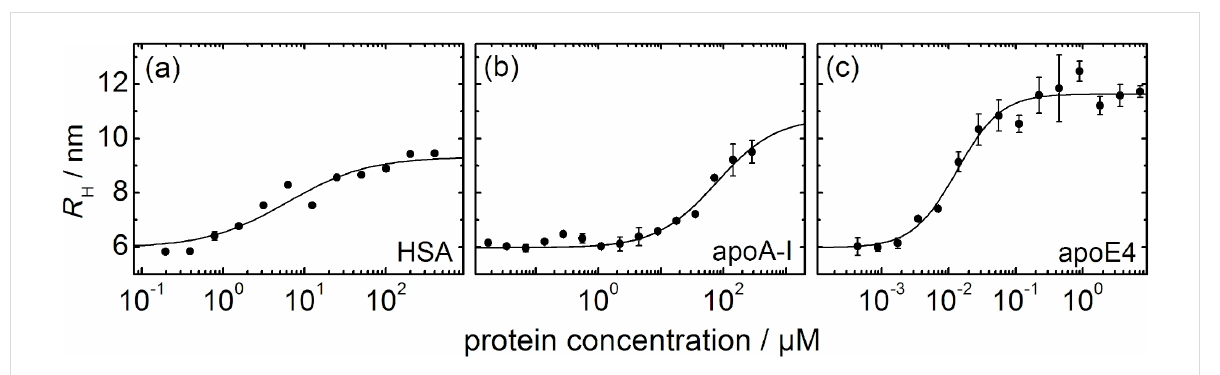
Figure 2: Hydrodynamic radius R H , of the FePt NPs, plotted as a function of the concentration of (a) HSA, (b) apoA-I and (c) apoE4. The curves (solid lines) were fitted according to Equation 3 and Equation 5; best-fit parameters are compiled in Table